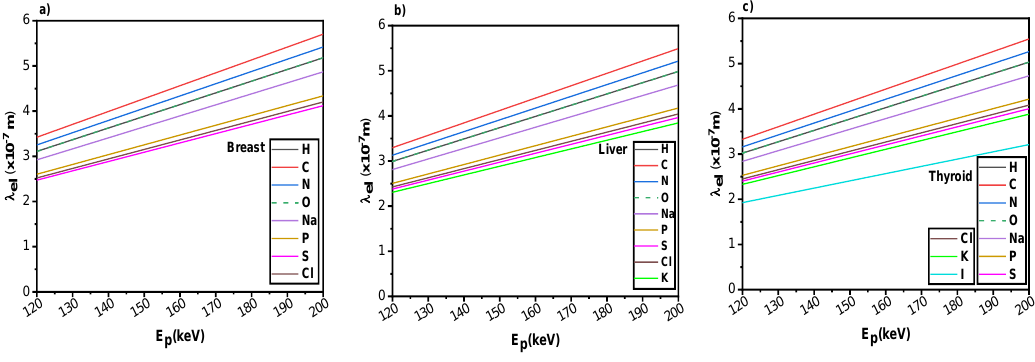
Figure 4: Elastic mean free path as a function of positron energy for (a) breast, (b) liver, and (c) thyroid.